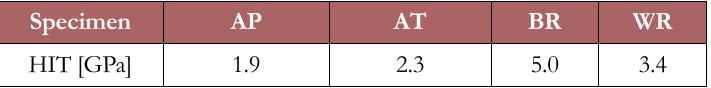
Table 2. Surface hardness values for tests on as printed (AP), as turned (AT), as burnished best result (BR) and worst result